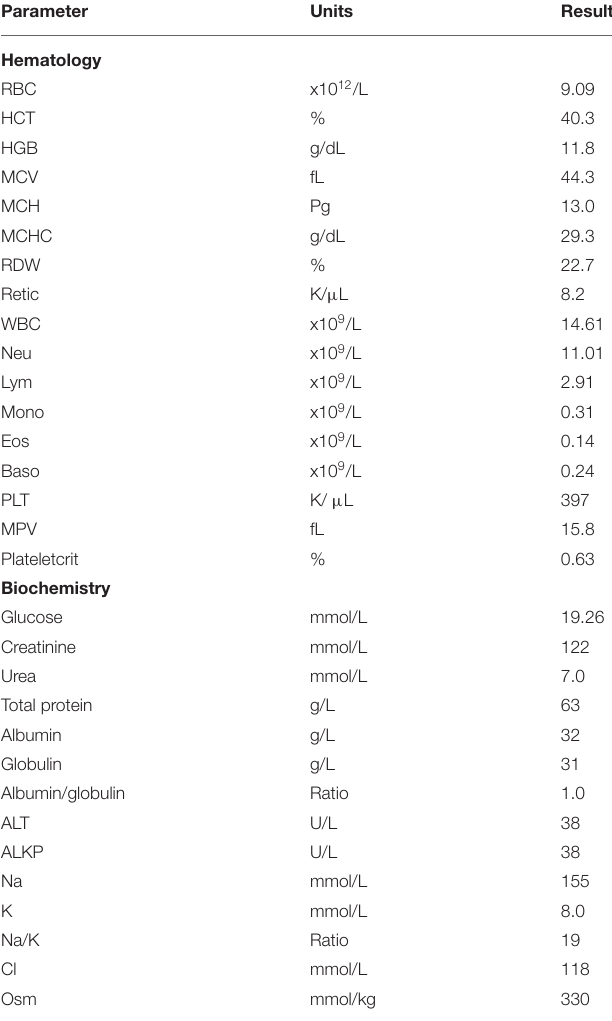
TABLE 1 | Hematology and serum biochemistry at time of urethral obstruction. Parameter Units